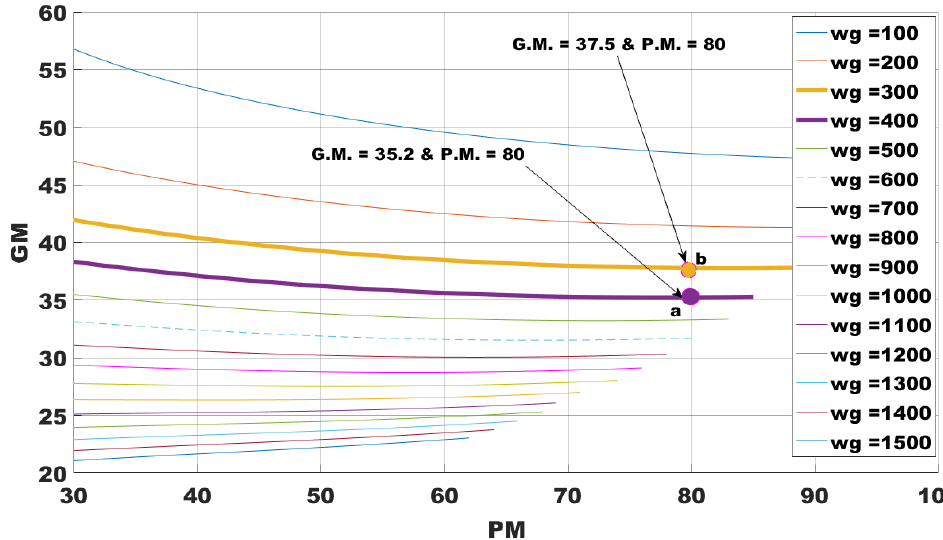
Figure 6. GM versus PM plot for selecting the robust stability specs.